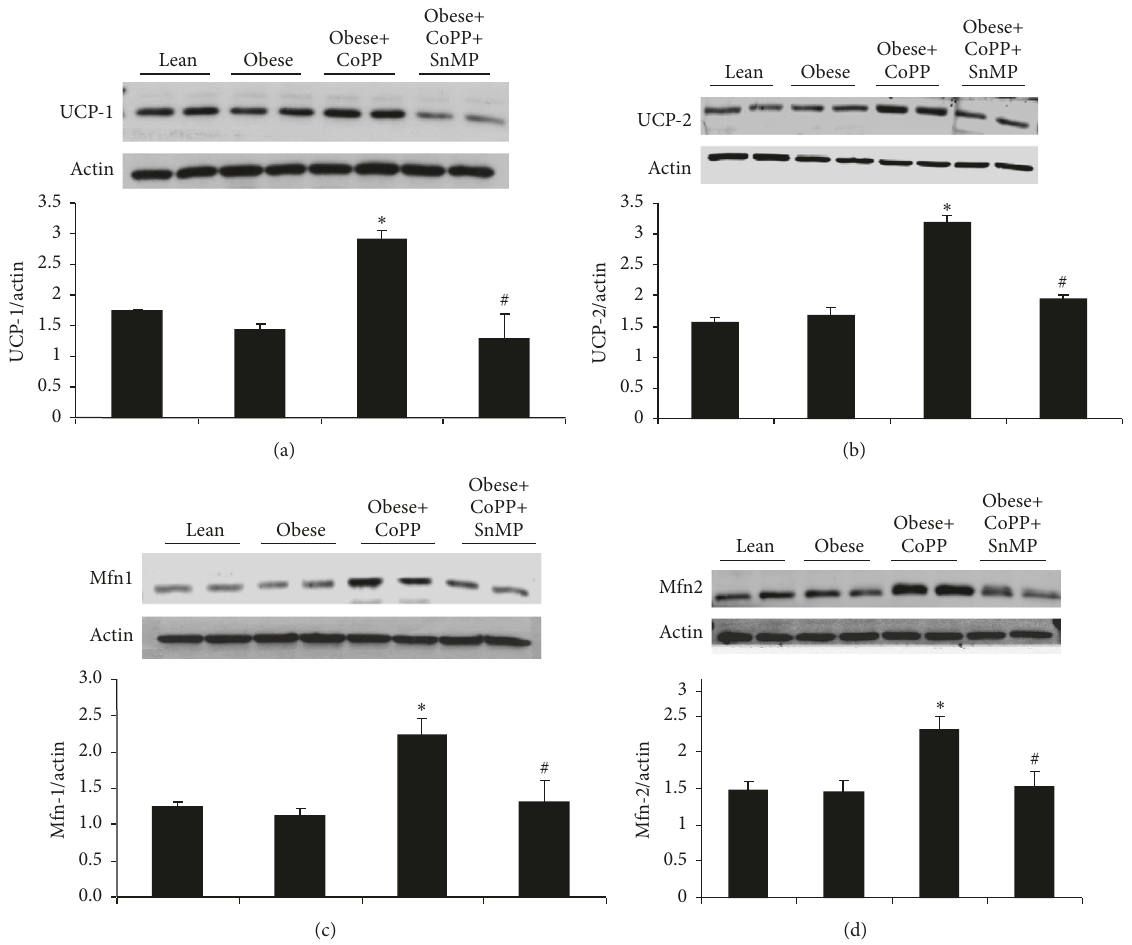
Figure 6: Effect of CoPP and SnMP administration on UCP-1 and UCP-2, and Mfn-1 and Mfn-2 protein levels in liver of lean and obese mice. Representative blots and associated graphs depicting densitometric analysis relative to 𝛽 -actin of (a) UCP-1, (b) UCP-2, (c) Mfn-1, and (d) Mfn-2. Results are mean ± SEM, 𝑛 = 3 -4, ∗ 𝑝 < 0.05 versus obese control; # 𝑝 < 0.05 versus obese treated with CoPP.